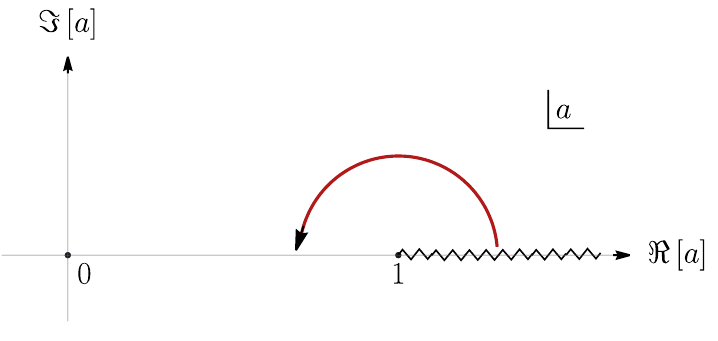
Figure 6 . The analytic continuation that takes one from a > 1 to a < 1